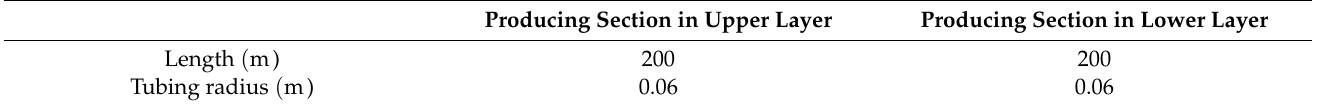
Table 9. The basic data of stepped well.